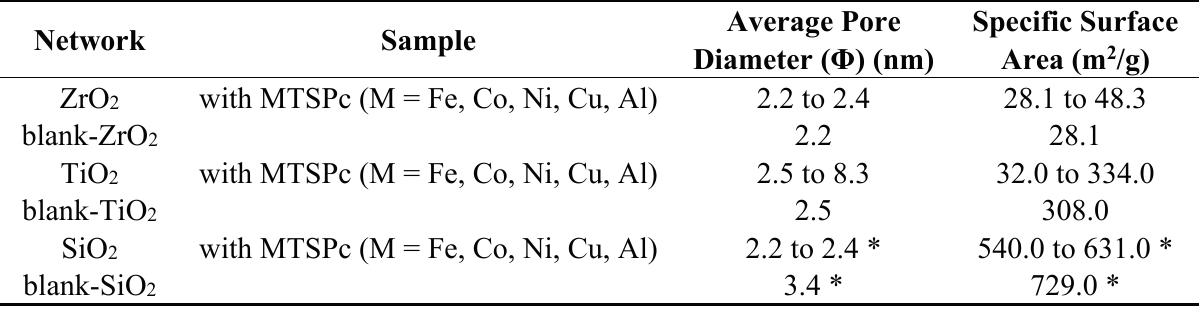
Table 1. Textural parameters evaluated from N 2 sorption isotherms on ZrO 2 or TiO 2 xerogels containing trapped MTSPc species. The calculated values are compared against those previously reported for similar silica systems